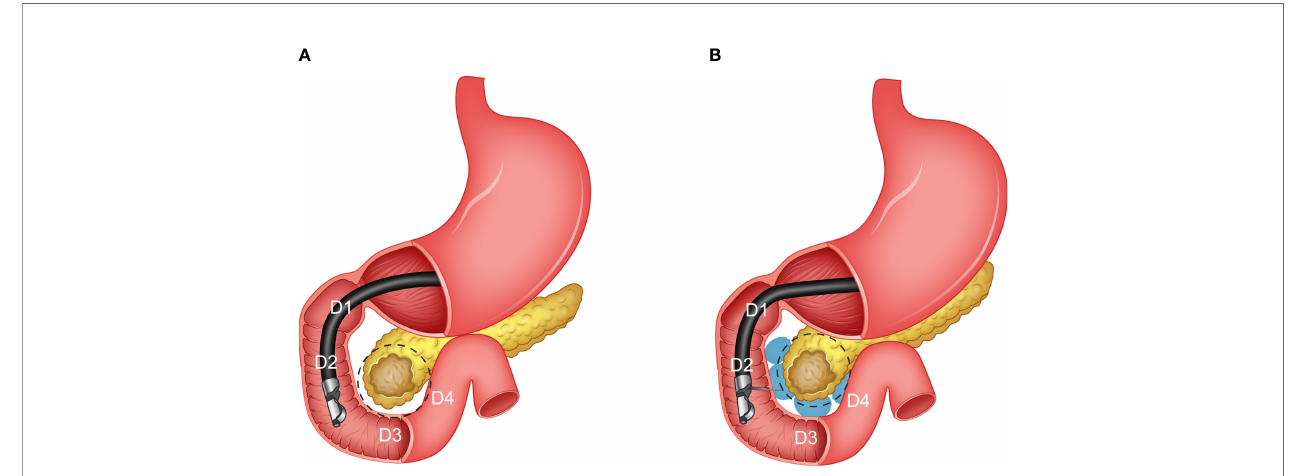
FIGURE 1 | An illustration of the pancreas and different sections of the duodenum (C loop). (A) Before the hydrogel injection (pre-injection), and (B) after the hydrogel injection (post-injection).